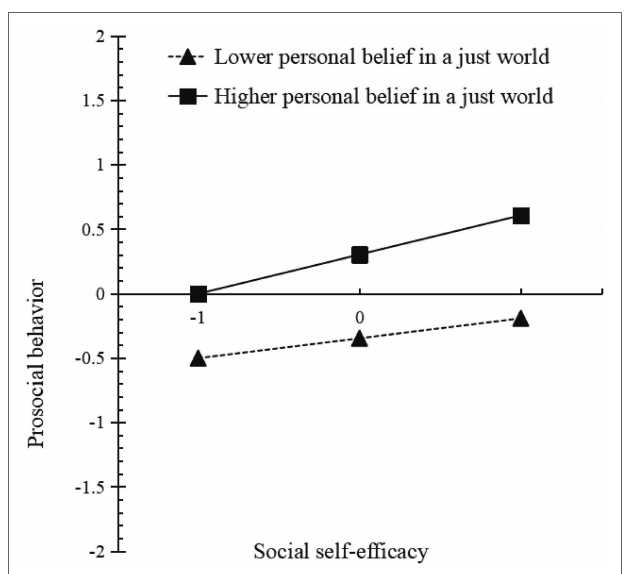
FIGURE 2 | The moderation of personal BJW between social self-efficacy and prosocial